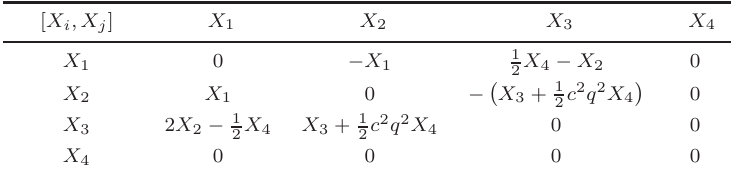
i ,X j ] = X i X j − X j X